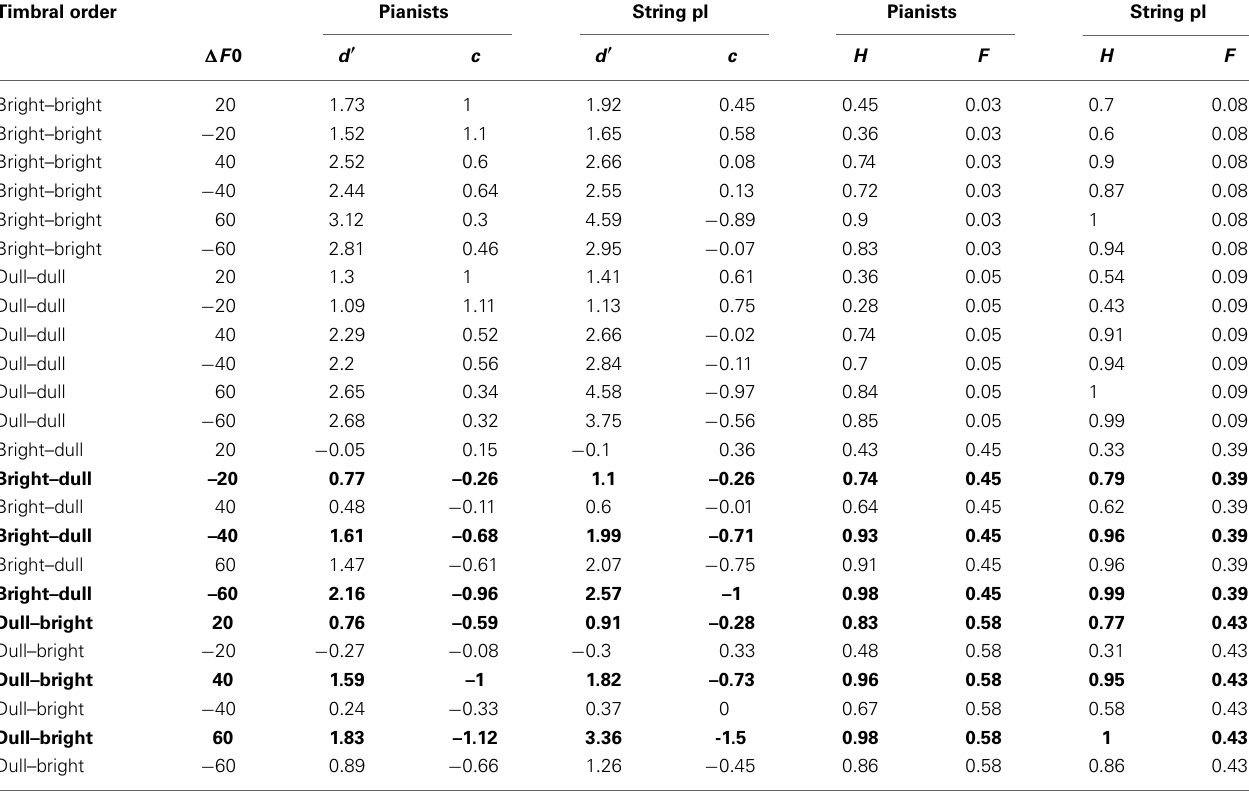
Table 2 | The d (cid:2) - and c -values as well as “hit” rates (H) and “false alarm” rates (F) of the responses of pianists and string players, calculated separately for each (cid:2) F0 (the value of which is given in cents) at four different timbral arrangements of tones.